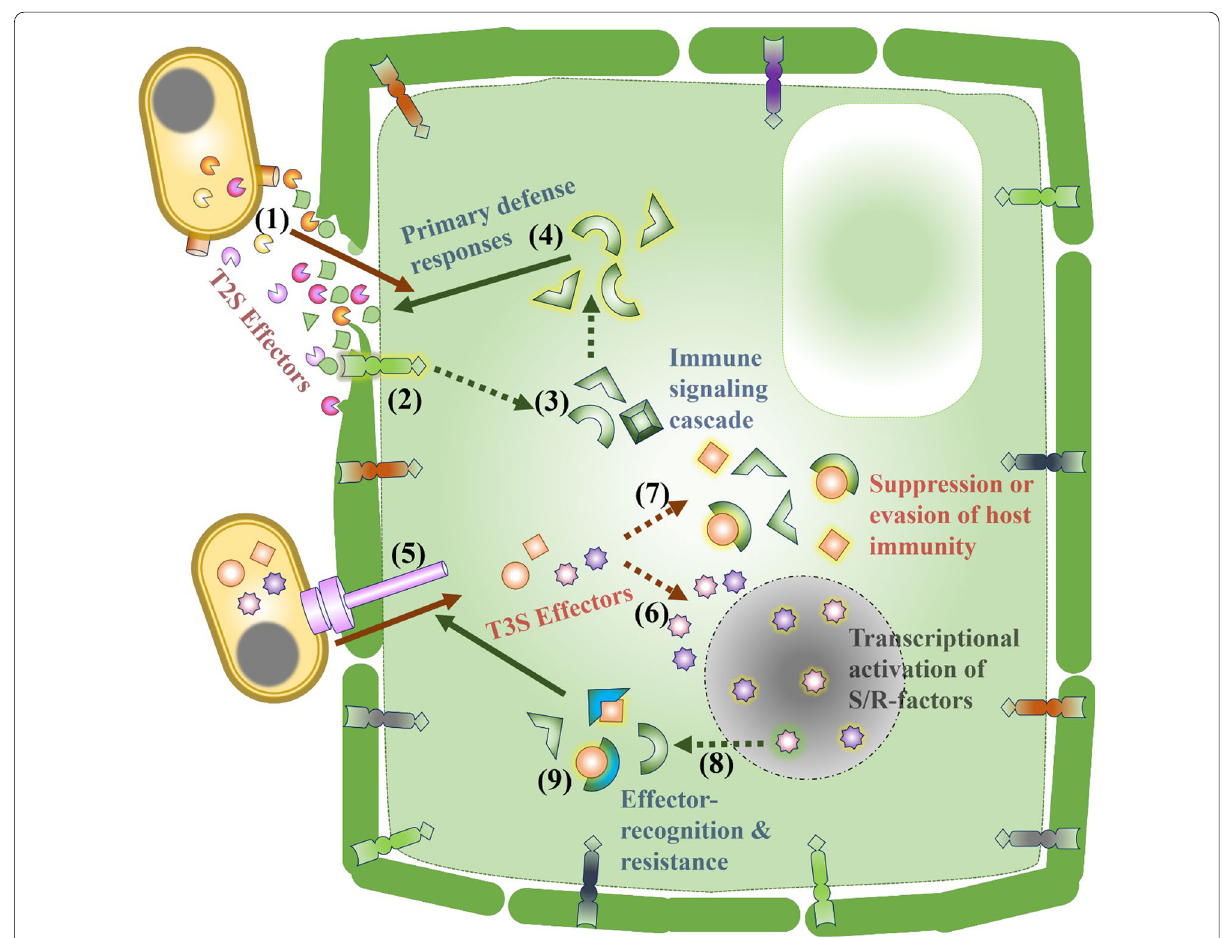
Fig. 1 Overview of rice- Xoo interaction with a focus on effectors during pathogenesis. The Xoo -rice interaction is an example of a complex multi-layered arms race between the pathogen and host with effectors playing remarkable roles in determining the pathogenicity. Xoo gains access to the plant cellular contents through digesting the cell wall. This is achieved via secreting an array of cell wall degrading enzymes (CWDEs, shown as different coloured pie shapes) through the type II secretion system (1). The damage-associated molecular patterns (DAMPs) from degradation products of CWDEs and pathogen-associated molecular patterns (PAMPs) are sensed by specific receptors at the plasma membrane (2). This activates downstream signalling cascades (3) such as MAPK signalling leading to activation of transcription factors and upregulation of defense genes, resulting in defense responses such as callose deposition, programmed cell death, and release of ROS (4). The effector proteins secreted via the type III secretion system are directly delivered into the plant cell cytoplasm (5). These effectors consist of transcription activator-like (TAL) effectors, which are DNA binding proteins that upregulate plant genes leading to further susceptibility (6) (Classical example is SWEET gene upregulation in Xoo -rice interaction). Another class of T3S effectors—non-TAL effectors -are involved in dampening the immune responses by targeting defense signalling pathways, working directly or indirectly by binding to plant proteins (7). The plant counters these effectors using multiple mechanisms. This involves the executor R genes whose transcription is activated by TAL effectors leading to strong immune response and thus resistance (8), and by resistance proteins that target effectors directly or indirectly